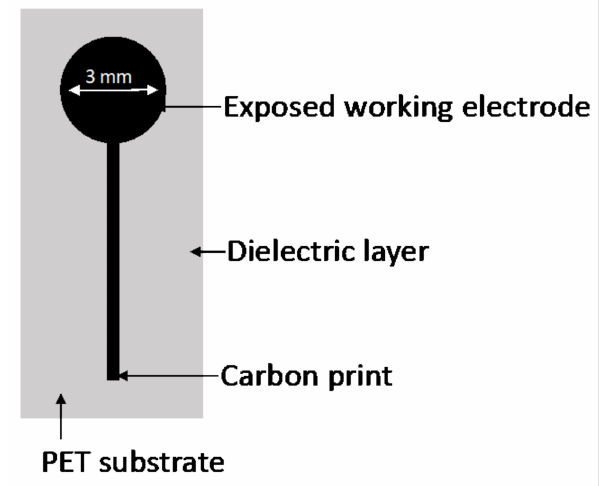
Figure 4. Composition of the screen-printed electrode used. Electrodes comprised a PET substrate, a carbon print and a dielectric layer print. The exposed carbon-paste area was 3 mm in